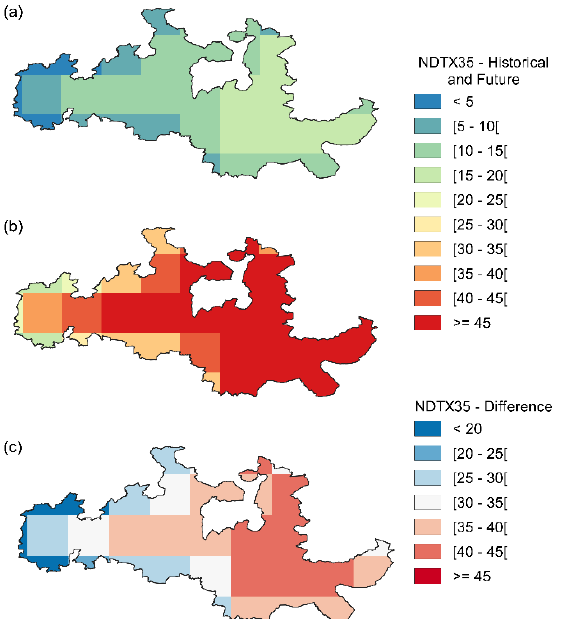
Figure 7. Ensemble-mean of the Number of Days with maximum temperature above 35 °C (NDTX35) for the Douro Wine Region, bias-corrected by quantile mapping, for the ( a ) historical (1989–2005), ( b ) future (2051–2080) under the RCP8.5, and ( c ) future historical difference.